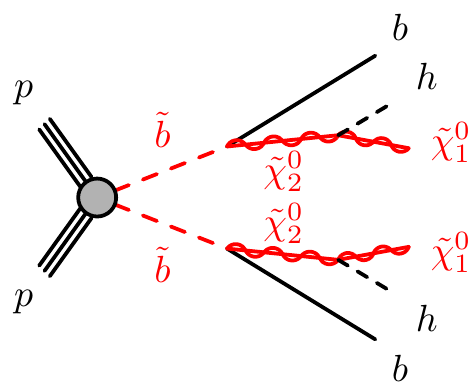
Figure 1. Graphical representation of the SUSY signal targeted by this analysis. Bottom squarks are produced in pairs and subsequently decay into b ~ (cid:31) 0 into h ~ (cid:31) 0 also with B = 1